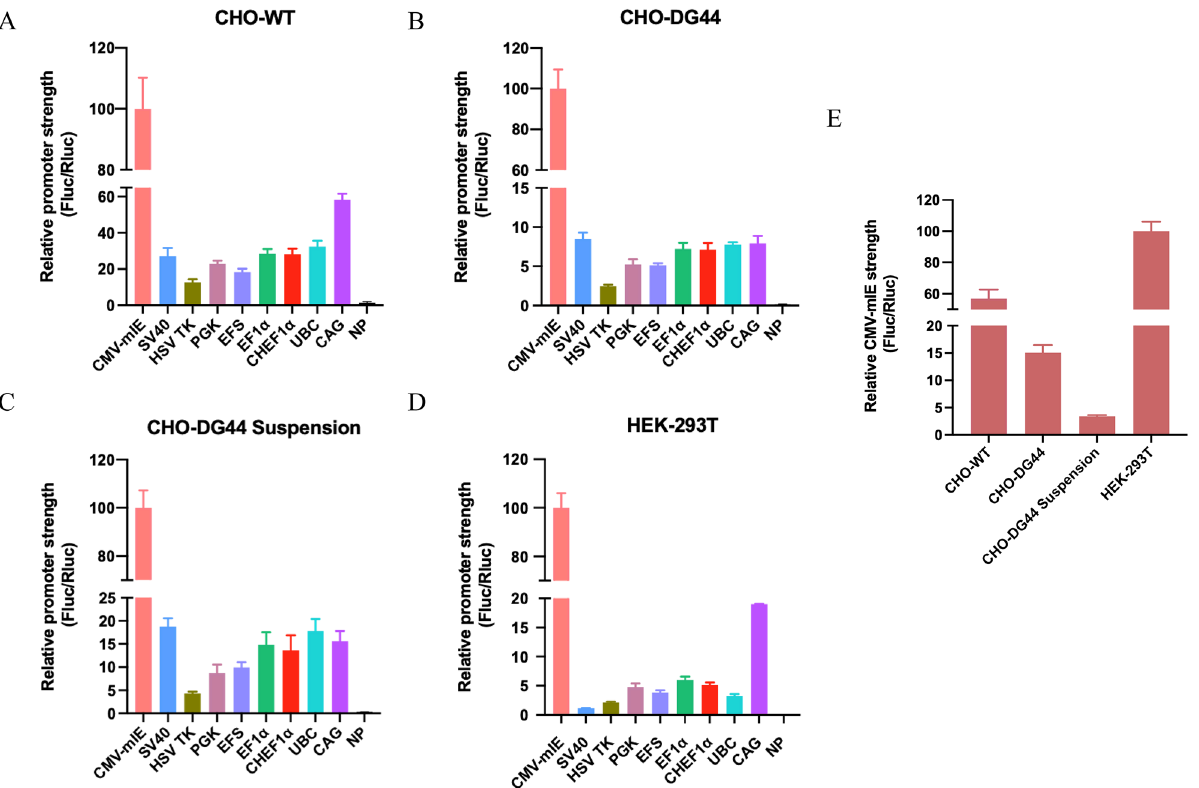
Figure 2. Analysis of promoter strength using the dual luciferase reporter system in transient expression settings. The activities of nine promoters was evaluated by dual luciferase assay at 48 h post-transfection. Fluc expression is driven by the variable promoter and enables the systematic comparison of promoter activities, while the Rluc signal is an internal control regulated by the invariable CMV-mIE promoter. The measurement of promoter strength based on the ratio of Fluc to Rluc signals was investigated in ( A ) CHO-WT, ( B ) CHO-DG44 adherent, ( C ) CHO-DG44 suspension, and ( D ) HEK-293T cell lines. The CMV-mIE promoter containing vector exhibited the highest value which was normalized to 100 in all cell lines. ( E ) Cross comparison of promoter activities across cell lines was examined by setting the CMV-mIE promoter as a standard. The relative activity in HEK-293T cell line was set at